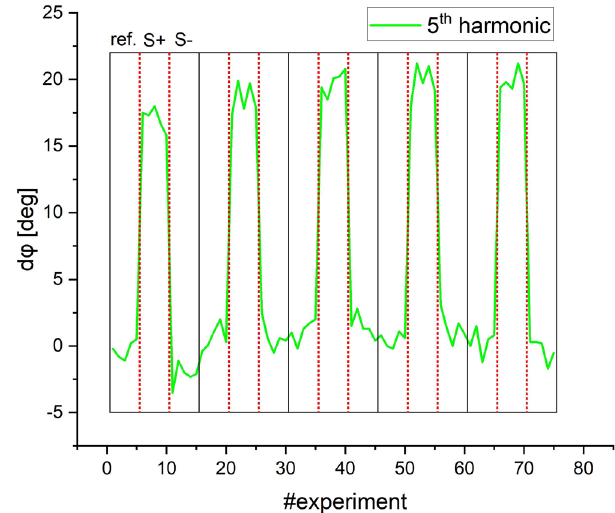
Fig. 6 | High-sensitive measurement with COMPASS. Results of the measure- ments with an optimized setup (Supplementary Note 5) on the 5 th harmonic of the binding statesof a dilutionof 1:500,000SARS-CoVS antibodies (corresponding to 0.33fmol per 50 µ l sample volume or ~7pM) on MNP-APTES-S1. The measurement sequence was 5 times reference sample ( ref ), 5 times binding sample ( S +), and 5 timesnon-bindingsample( S − )andwasrepeated fi vetimesresultingin75individual experiments. Note that no visible difference between reference ( ref ) and non- bindingsample( S – )isvisible.Theacquisitiontimewas10msperexperimentwitha repetition time of 1s. All samples have been prepared only seconds before